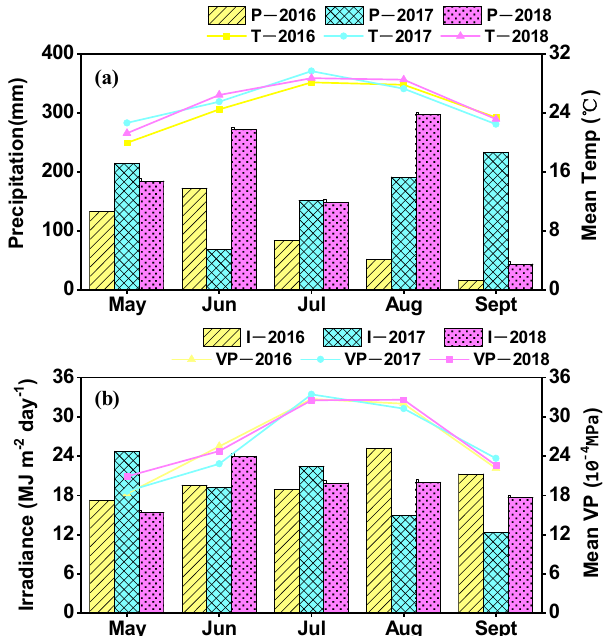
Figure 1. ( a ) Monthly precipitation (P) and mean air temperature (T), ( b ) irradiance (I) and mean vapor pressure (VP) at the Xinmaqiao Comprehensive Experiment Station of Irrigation and Drainage, Bengbu, China (117°21 ′ 34 ″ E, 33°08 ′ 56 ″ N) during the rice growing season (May to September) in 2016–2018.